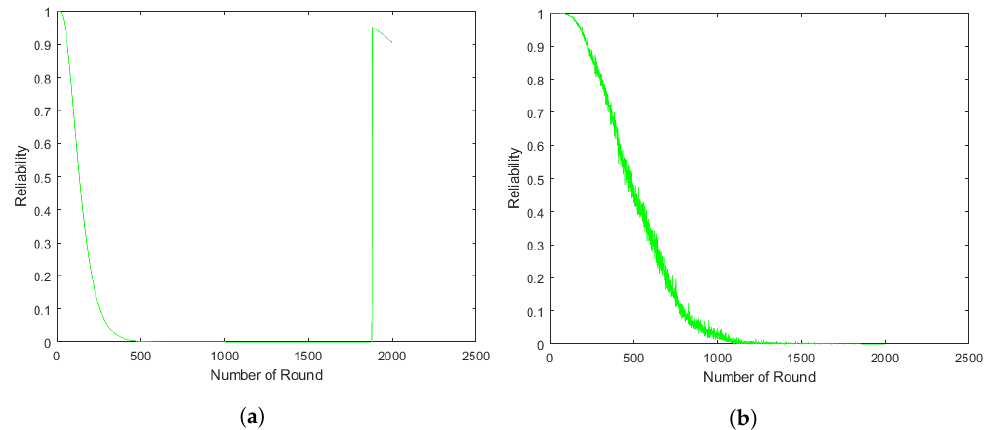
Figure 23. Multi-chain single-hop mobile CHs energy reliability-based proposed RBD: yellow